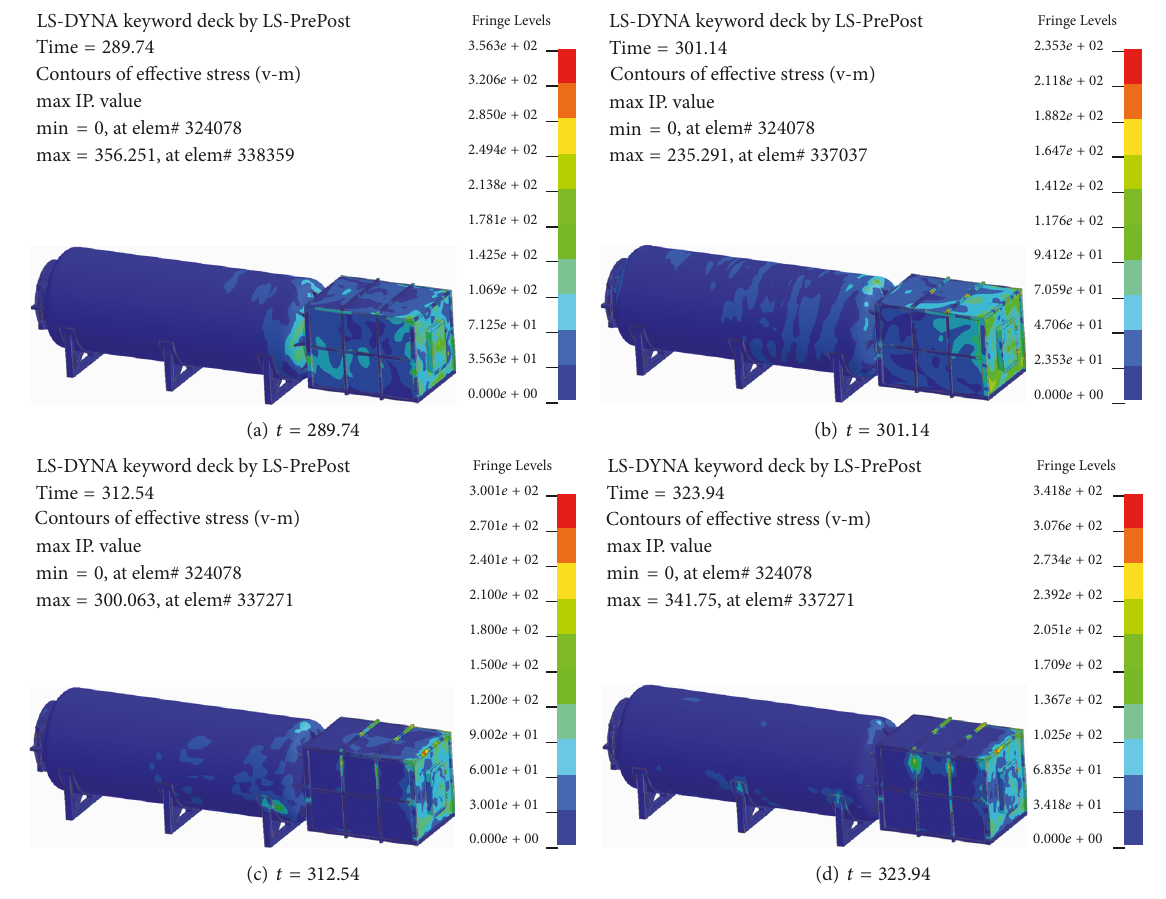
Figure 9: Stress change for the rescue capsule.